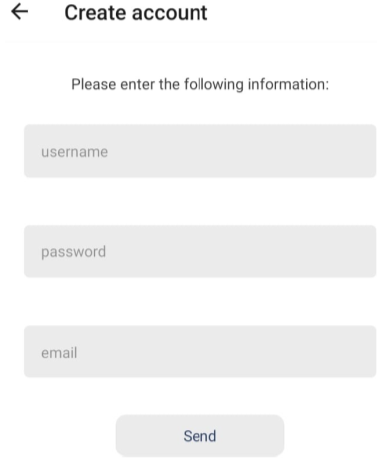
Figure 2. Create-account screen.